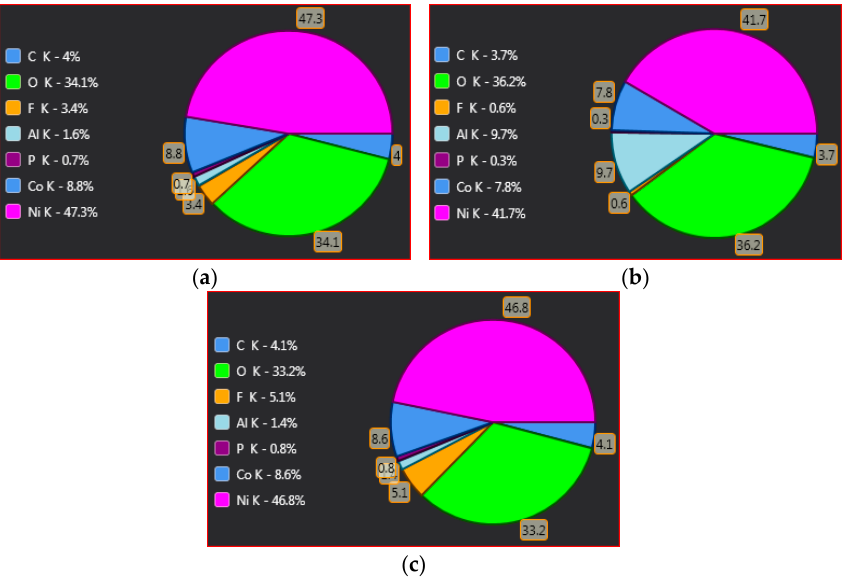
Figure 10. Composition % of the cathode of the cell (EDX analysis): ( a ) new, ( b ) overdischarged with a DOD% = 110%, ( c ) over-discharged with a DOD% =